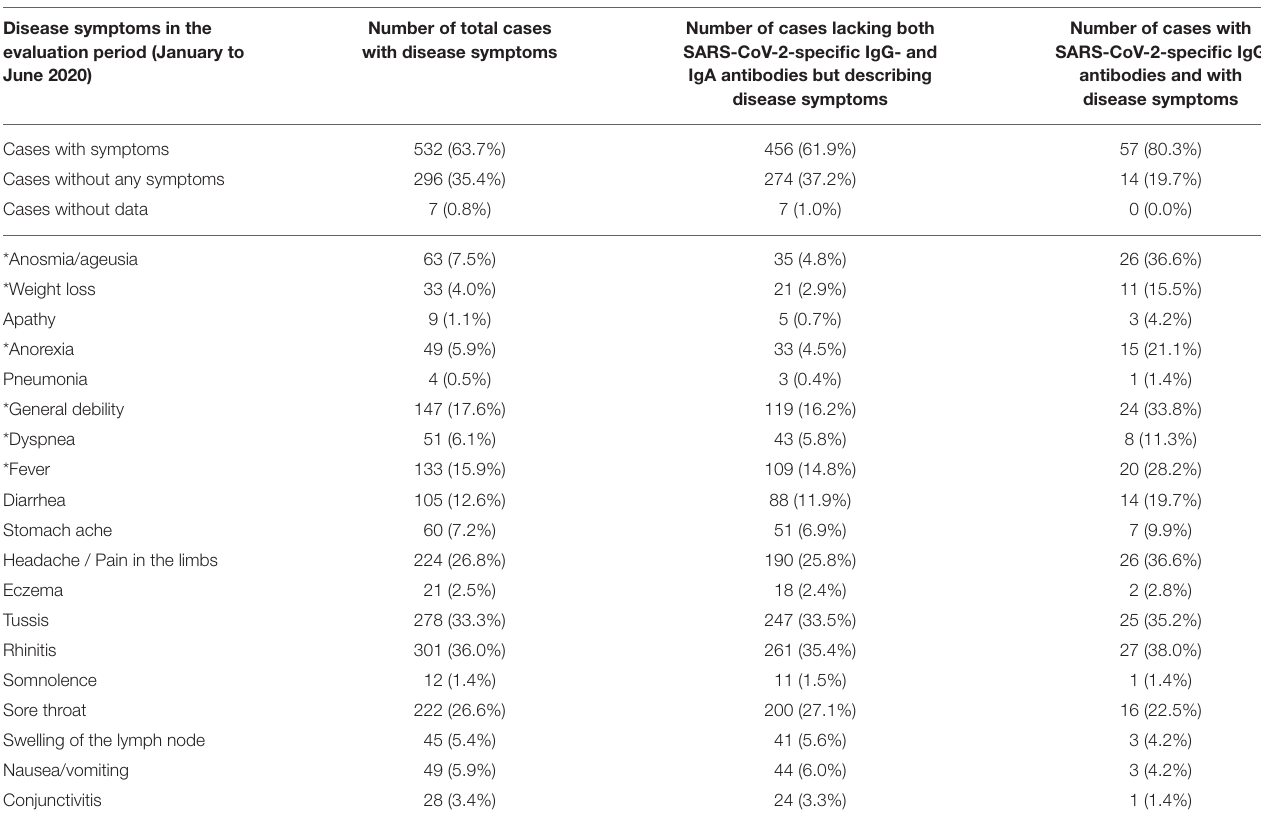
TABLE 1 | Disease symptoms in the tested population. Disease symptoms in the evaluation period (January